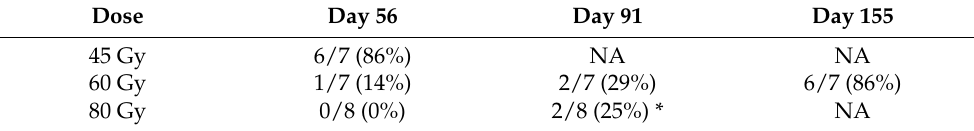
Figure 2. Macroscopic imaging following irradiation and scoring of acute/late side effects. ( A ) Representative images of the appearance of the skin as function of the irradiation dose delivered. * Indicates the date of surgery for excisional wounds created in the irradiated zones and normal skin. Red arrows indicate the day of surgery for incisional wounds. ( B ) Graphical representation of the skin surface area presenting redness over a 22-week period (mean data and standard deviation for n = 7–8 mice per group). Table 1. Number of mice presenting visually asymptomatic skin at specified time points.